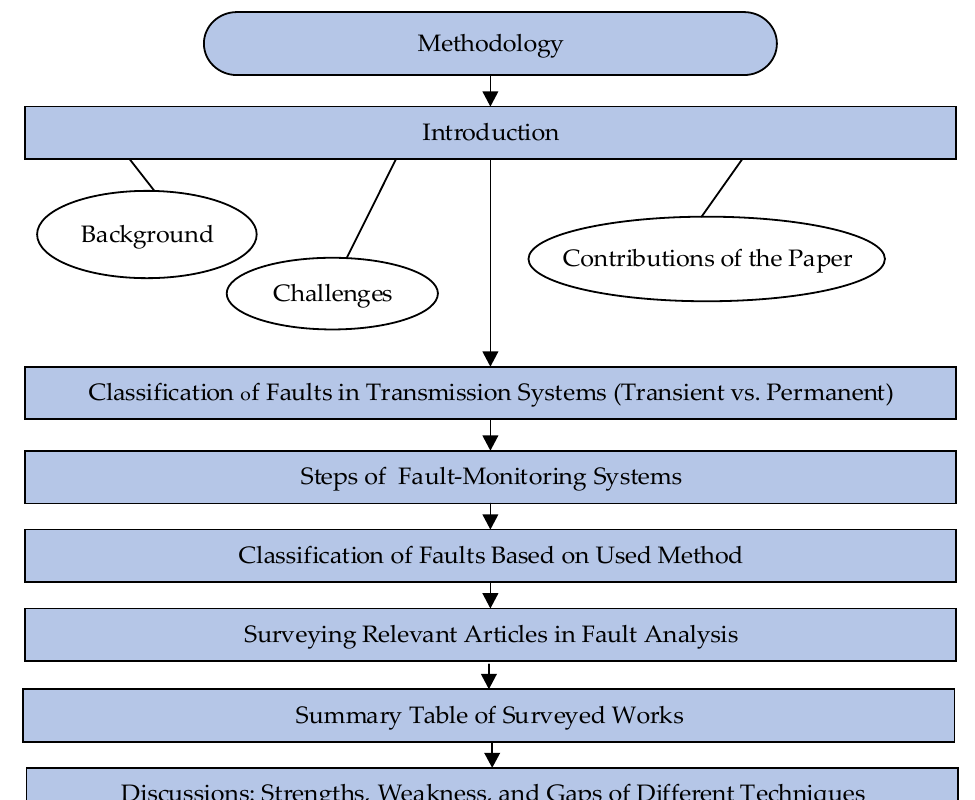
Figure 2. The process flow of our review methodology.